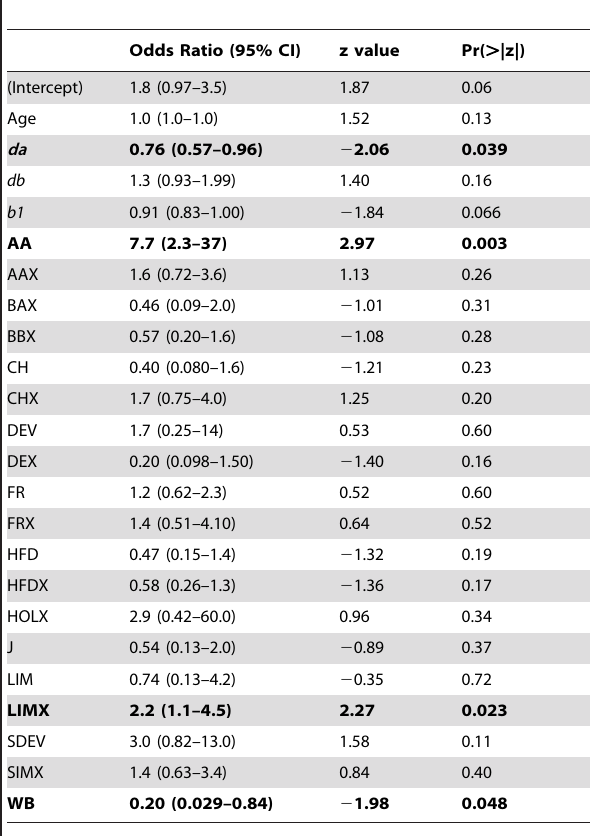
Table 2. Test and animal factors associated with probability of being the ‘22’